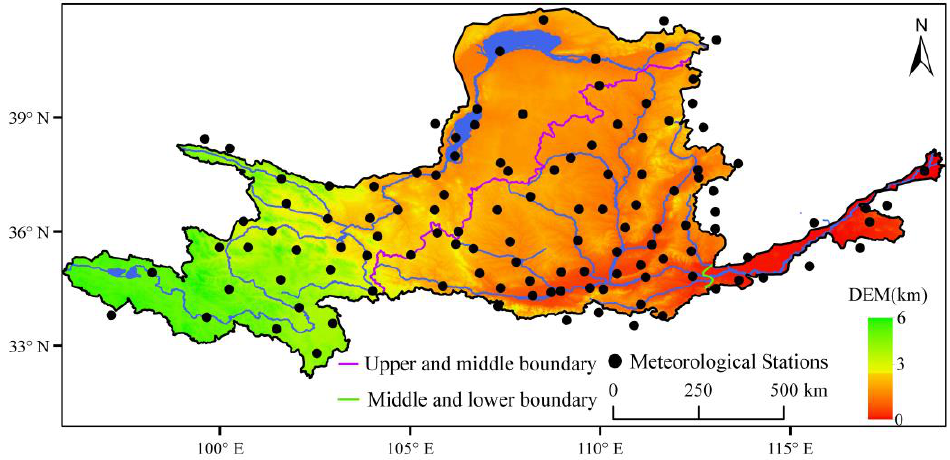
Figure 1. Distribution of meteorological stations in the Yellow River Basin.